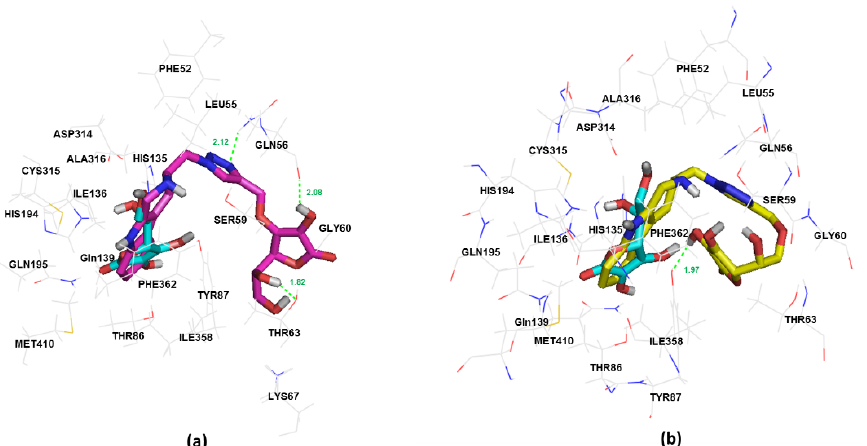
Figure 7. Binding modes of ascorbic derivatives and vitamin C transporter 2 (pdb code: 4RP9). ( a ) Binding position of 5c (magenta) compared with ascorbic acid (cyan), and ( b ) binding position of 2c (yellow) compared with ascorbic acid (cyan).